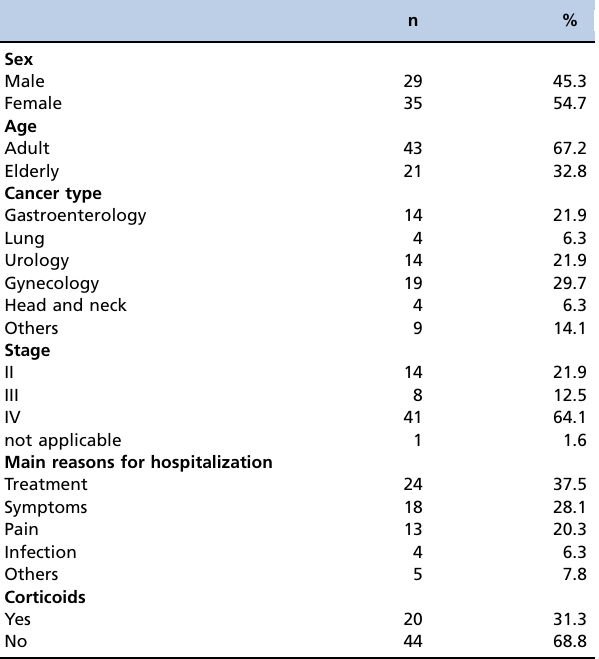
Table 1 - Sociodemographic and clinical characteristics of the study sample.